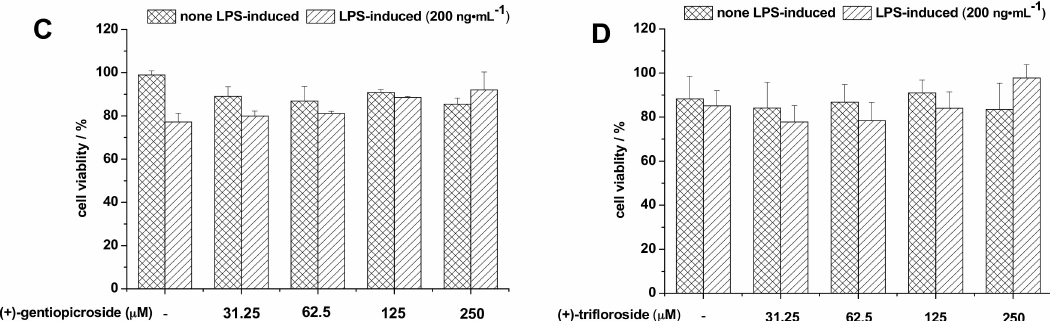
Figure 5. Effect of ( A ) longanic acid; ( B ) swertiamarin; ( C ) gentiopicroside; and ( D ) trifloroside on the cell viability of microglial BV-2 cells in LPS-treated or non-LPS-treated. BV-2 cells were treated with various concentrations of ( ± )-glycosides for 24 h and cell viabilities were monitored by crystal violet staining. Data are presented as means ± SD ( n = 3 in each